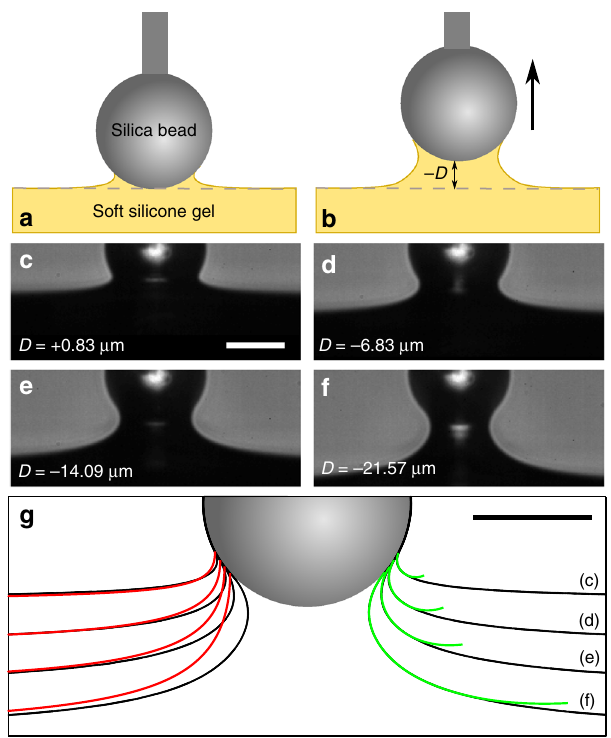
Fig. 1 A solid meniscus in soft adhesion. a , b Schematic of the experiment at a initial contact and b during quasi-static pull. c – f Raw snapshots of a 17.4- μ m-radius sphere adhered to an initially fl at, compliant ( E = 5.6kPa) silicone gel substrate as it is pulled quasi-statically from c fi rst contact to f the last measured stable position ( scale bar in c : 20 μ m). g Mapped deformation pro fi les ( black points ) corresponding to ( c ) – ( f ), with predictions of classic elastic theory 17, 18 overlaid at left ( red lines ), and best- fi t constant total curvature surfaces overlaid at right ( green lines ) ( scale bar : 20 μ